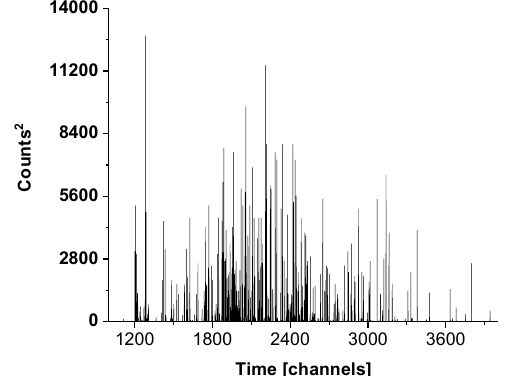
7. Autocorrelation function calculated after subtraction of two successive reactor bursts